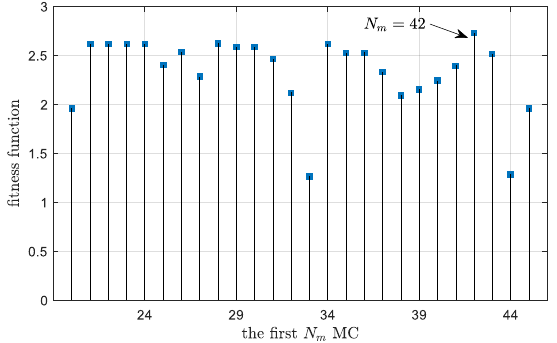
Figure 21. Fitness function of damage case I, for the ITR method.